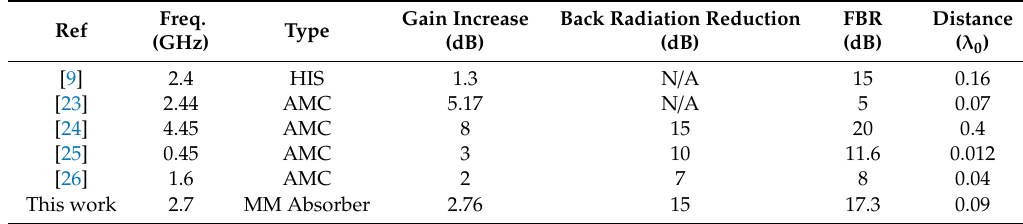
Table 3. Performance comparison with previous studies.